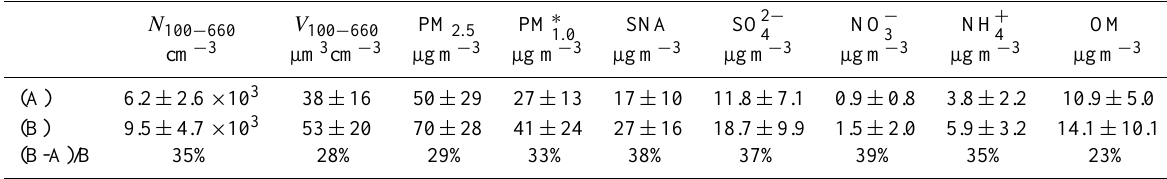
Table 4. Influence of regional transport on fine particles at BG.